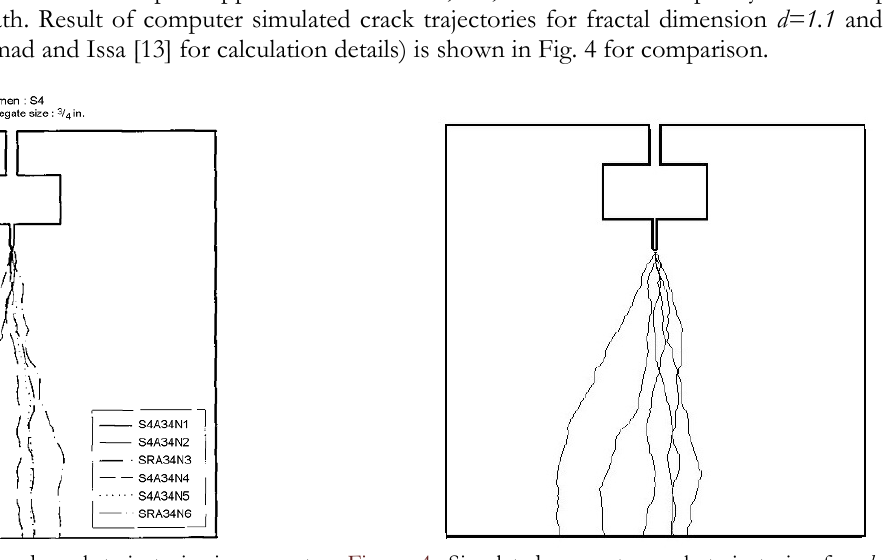
Figure 3: Experimentally observed crack trajectories in concrete specimens.